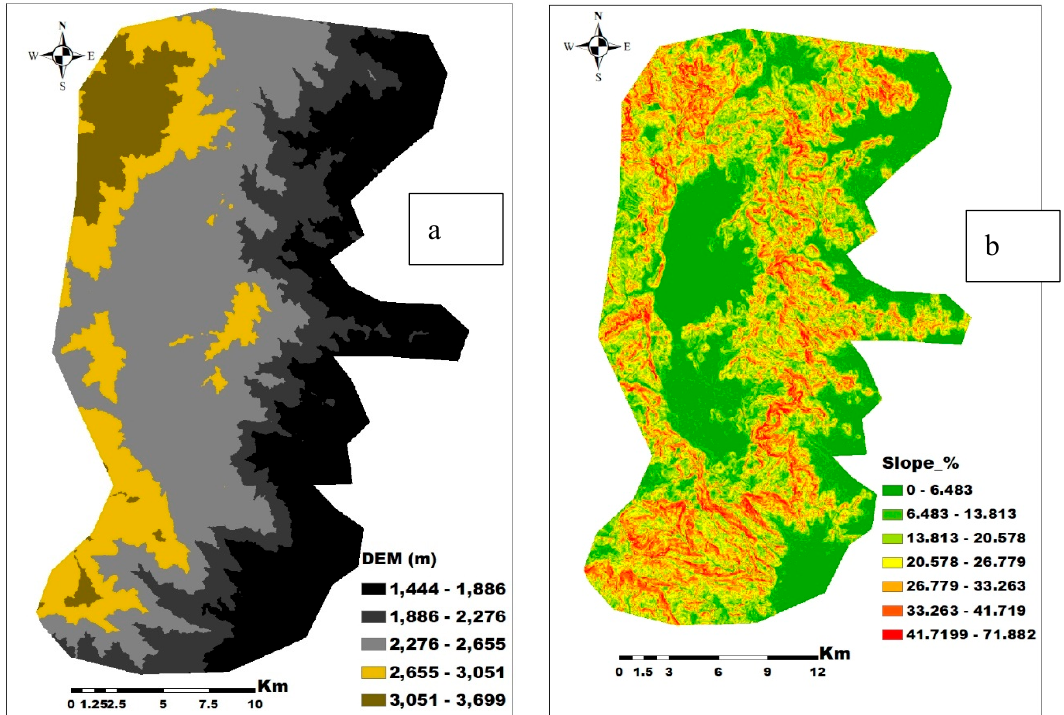
Figure 3. ( a ) Digital elevation model (m) and ( b ) Slope (%) map of the catchment.